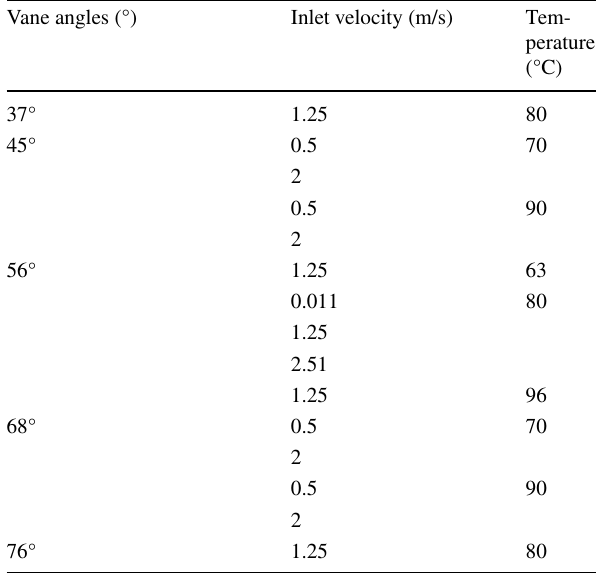
Table 2 Combinations of runs, or boundary conditions, generated by DOE Vane angles (°)